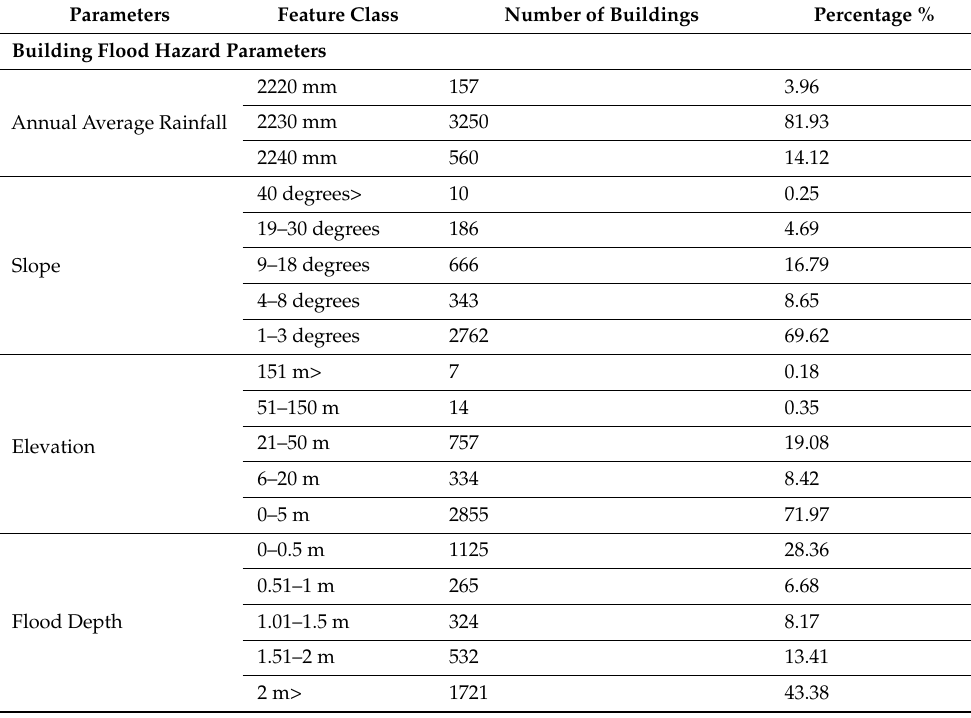
Table A1. Feature count of the building flood hazard